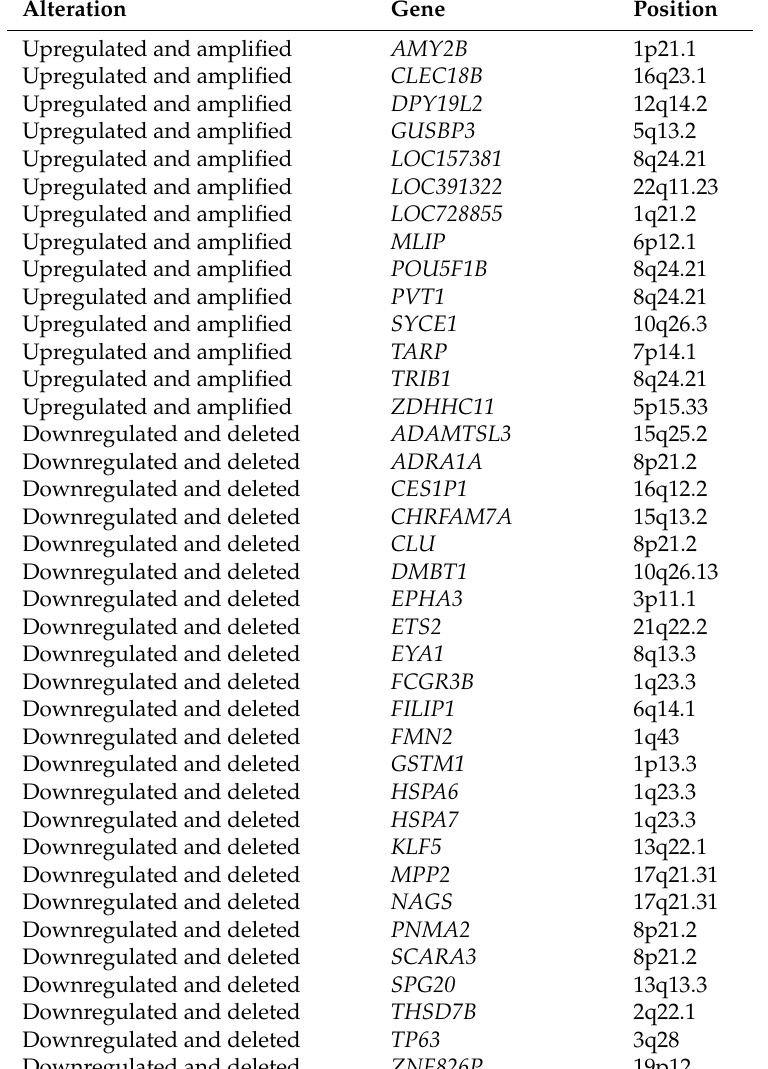
Table 1. Altered genes from the combined analysis of gene expression and copy number alterations in aggressive prostate